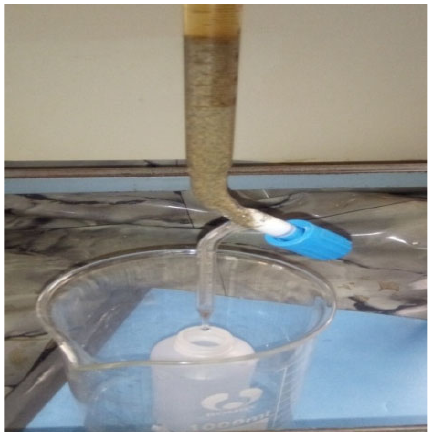
Figure 1. Laccase purification through column chromatography.